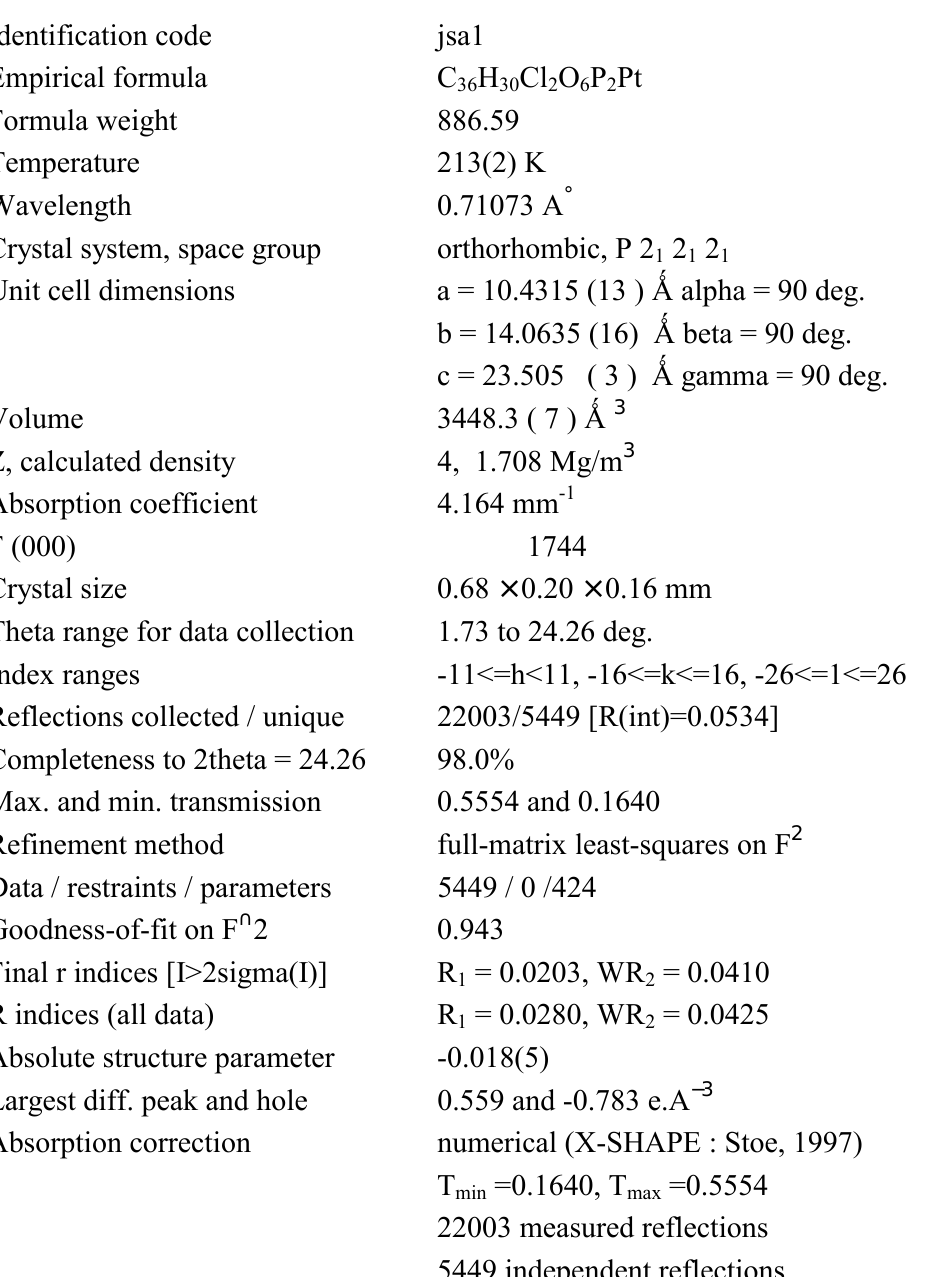
Table 1. Crystal data and structure